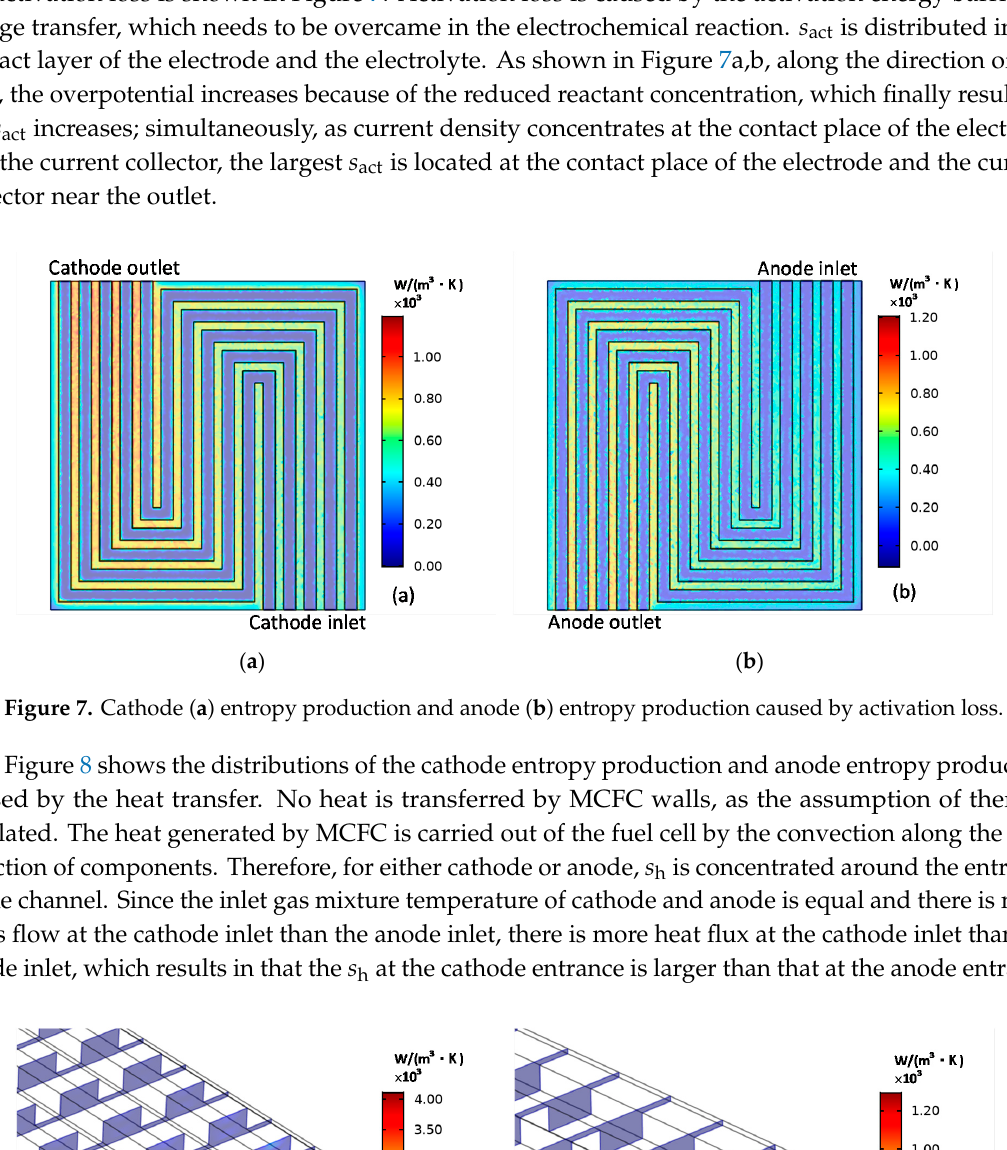
Figure 6. Cathode ( a ) entropy production and anode ( b ) entropy production caused by ohmic loss. The distributions of the cathode entropy production and anode entropy production caused by